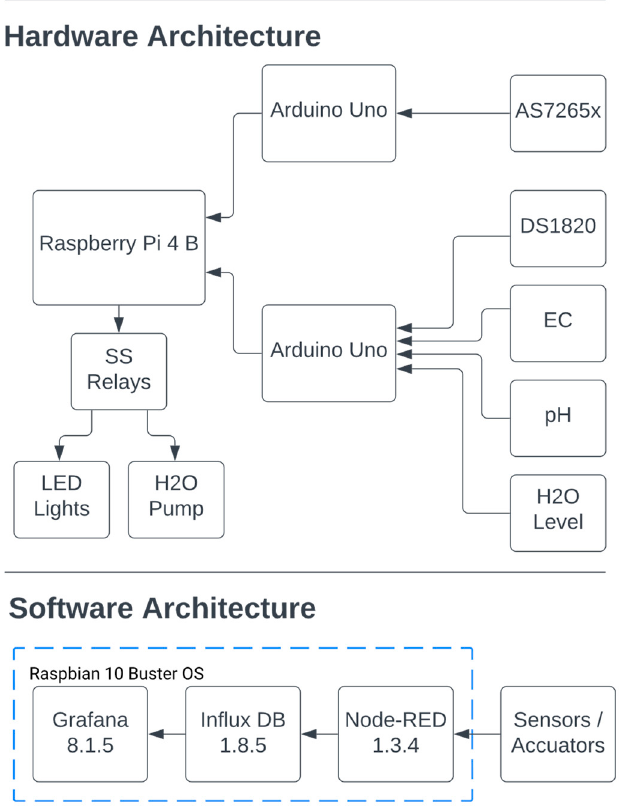
Figure 5. Hardware and software architecture of the NutriSpec sensor system.